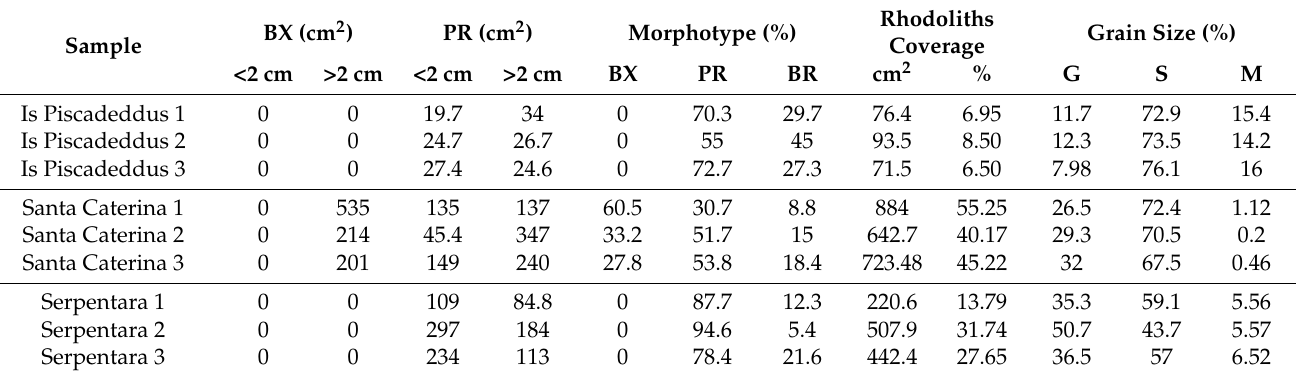
Table 2. Coverage of live rhodoliths and grain size analysis. Boxwork (BX) and praline (PR) have been subdivided in rhodolith with the long axis greater or lesser than 2 cm. In the first four columns, coverage is expressed in cm 2 . Coverage (%) is expressed per morphotype (column 5), and as total (cm 2 and %, column 6) For grain size (column 7): G for gravel. S for sand, and M for